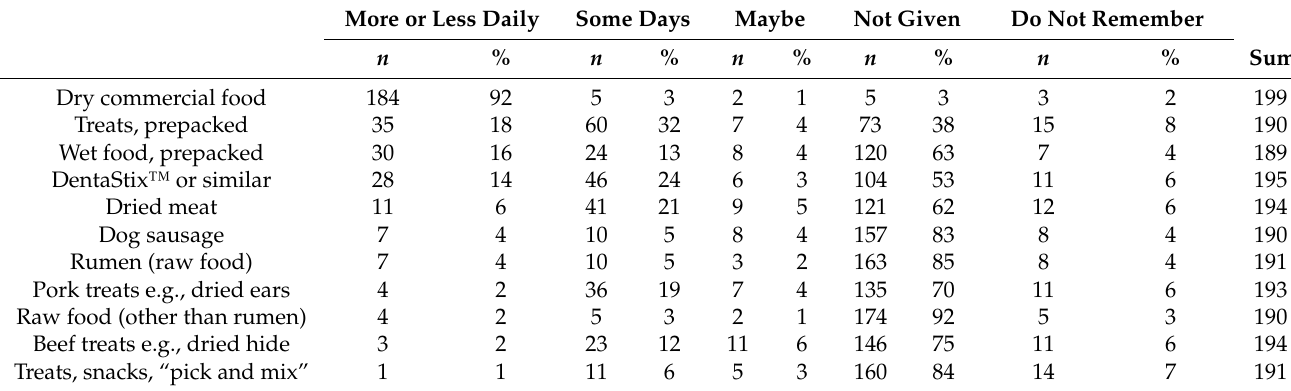
Table 2. Description of different foods and treats given to registered case dogs in an outbreak of acute haemorrhagic diarrhoea. Online survey to veterinarians, Norway, September 2019.